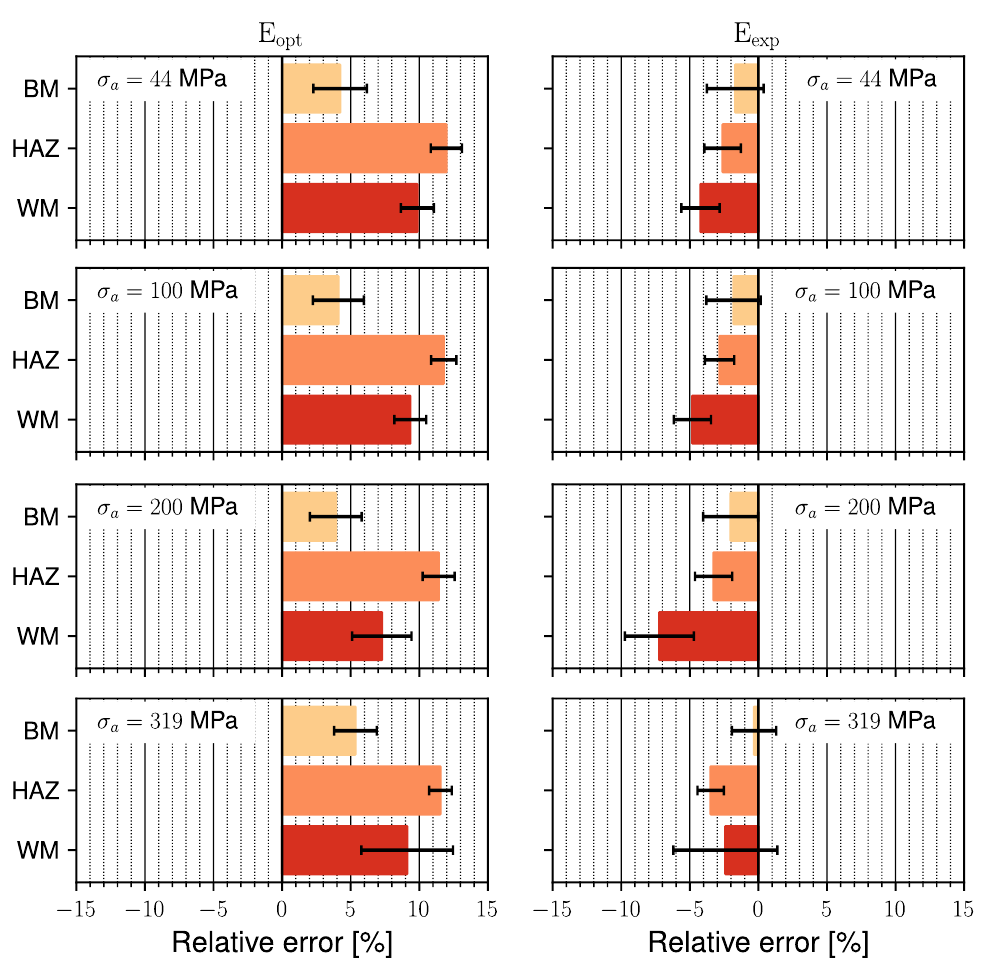
Figure 10. The average relative error in strain range estimation. The standard deviation of the relative error is presented using error bars. A negative relative error indicates that the V–C model underesti- mates the strain range, while a positive relative error indicates that the V–C model overestimates the strain range. The number of stress–strain signals considered for each material are n = 3 for the BM, n = 1 for the HAZ, and n = 2 for the